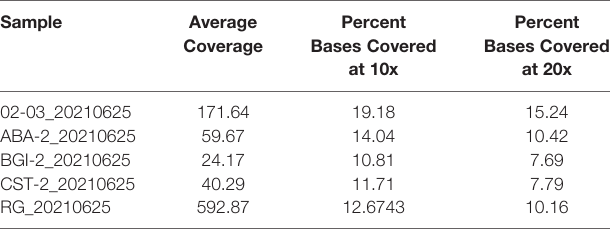
TABLE 2 | Average Coverage and Percent Bases Covered at 20x.